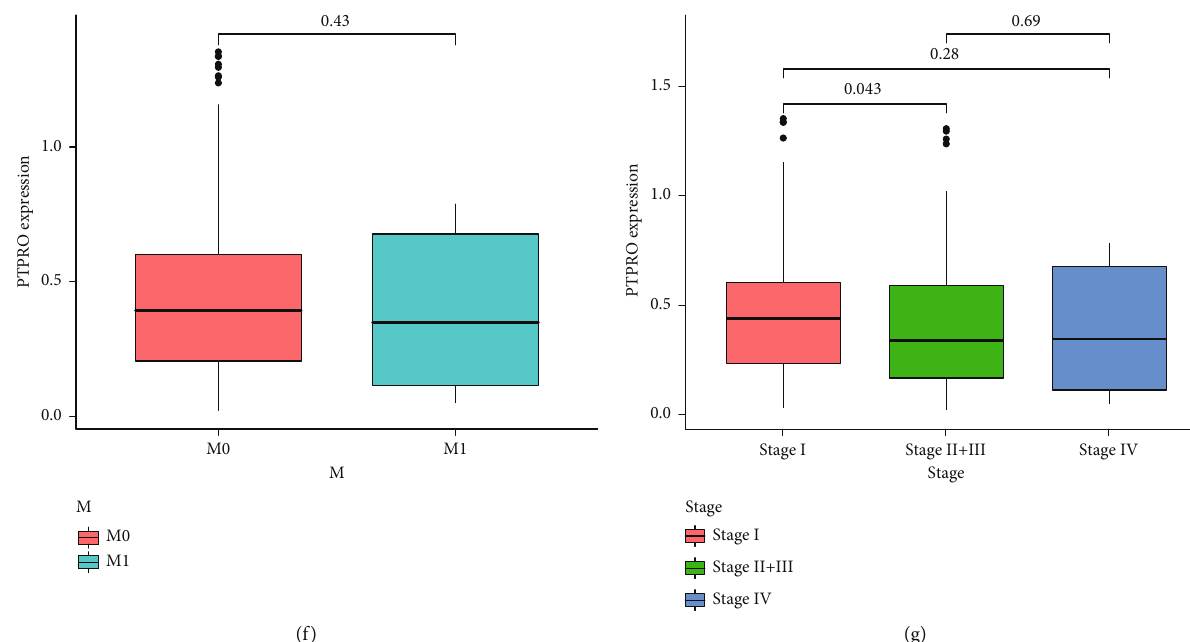
Figure 2: Correlation between the expression level of PTPRO and clinical features in LUAD. (a) Heatmap of the clinical relevance of PTPRO expression level. (b – g) Di ff erences in PTPRO expression level between di ff erent clinical subgroups (gender, age, TNM and